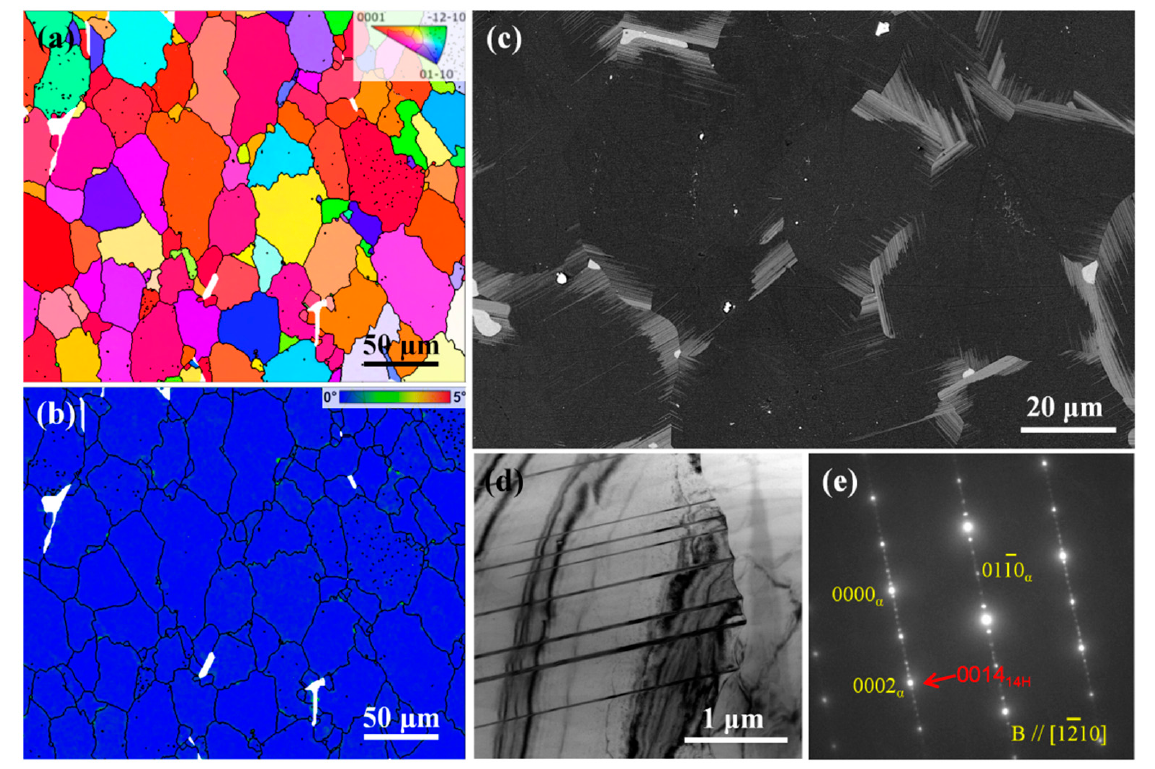
Figure 4. Microstructure of the T4 alloy: ( a ) IPF and ( b ) KAM maps; ( c ) SEM image; ( d ) bright-filed TEM image, and ( e ) corresponding SEAD pattern. Notes that red arrows represent superstructured la tt ice.